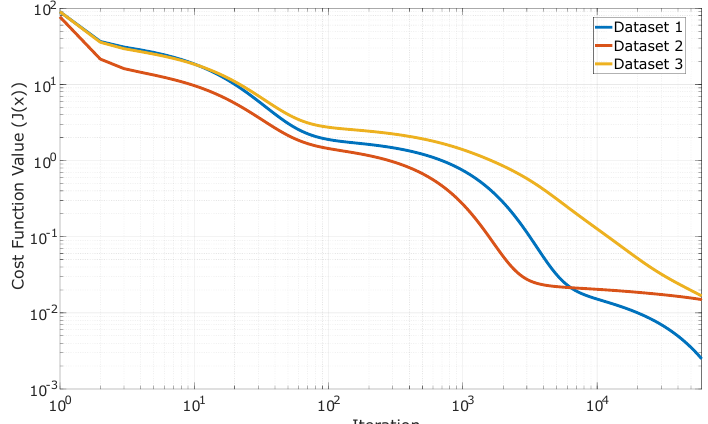
Figure 3. Algorithm’s convergence for three different